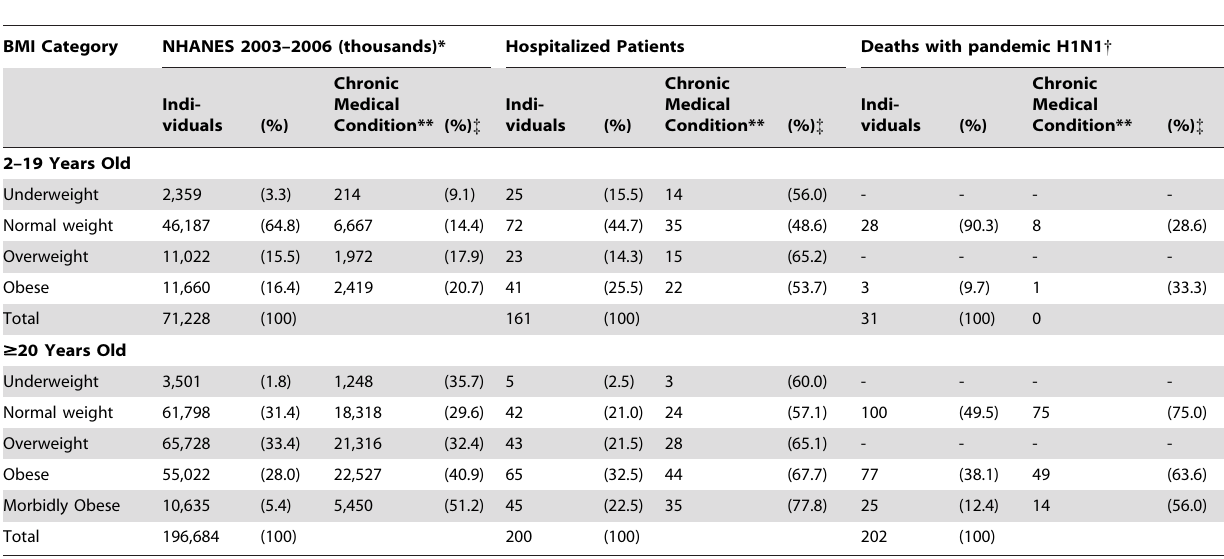
Table 1. Number and percent of persons with ACIP-recognized chronic underlying medical conditions, by category of body mass index